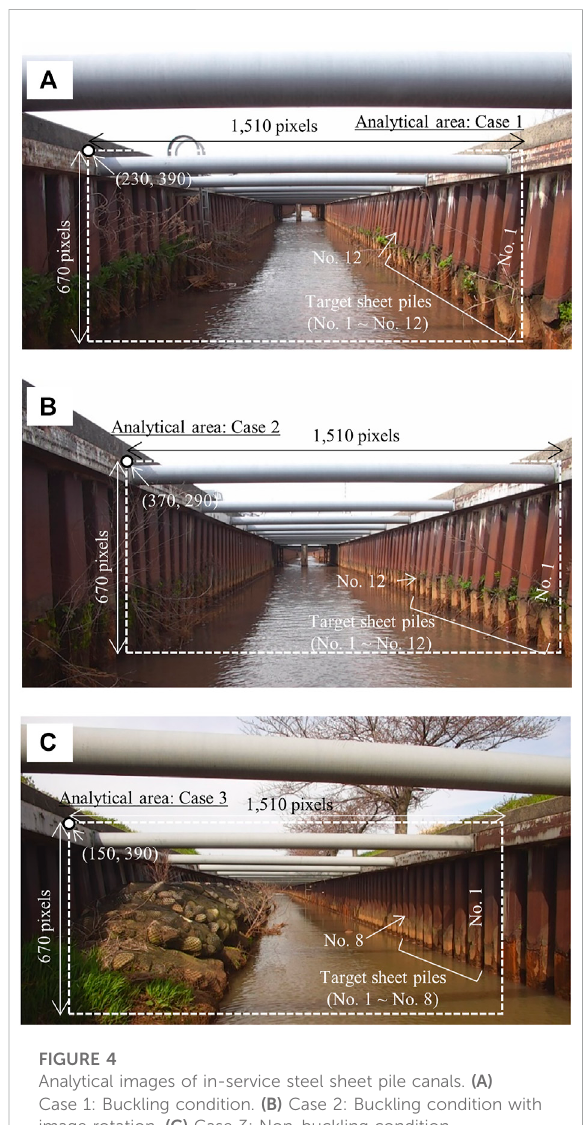
FIGURE 4 Analytical images of in-service steel sheet pile canals. (A) Case 1: Buckling condition. (B) Case 2: Buckling condition with image rotation. (C) Case 3: Non-buckling